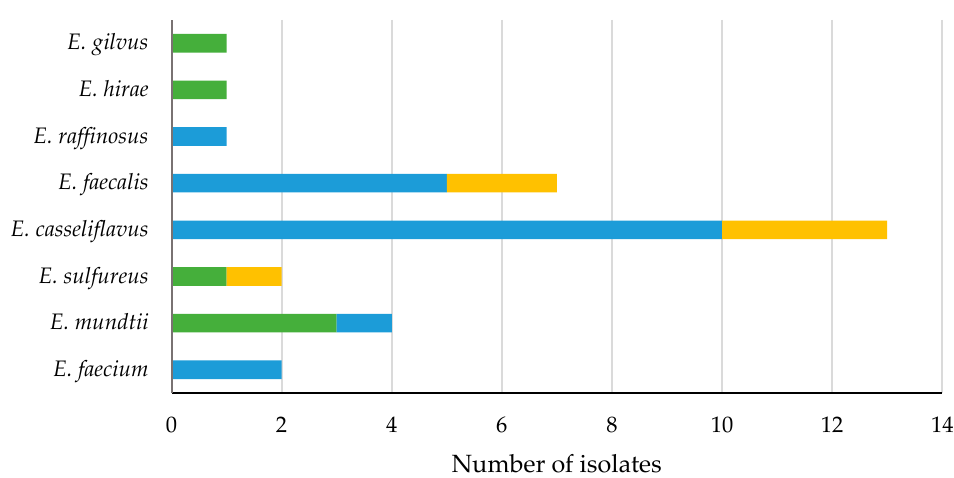
Figure 3. Levels of antibiotic resistance in different species of enterococci ( n = 31) isolated from fresh produce.